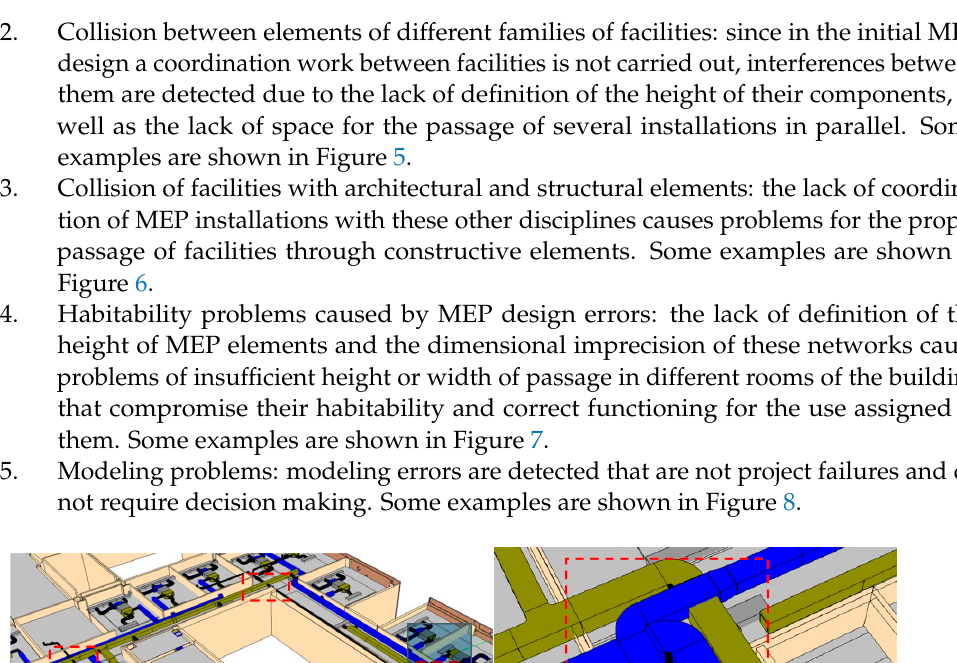
Figure 4. Virtual representation of collision between air conditioning ducts in different scales. BIM Model. The general view ( left ) and the deailed view ( right ).